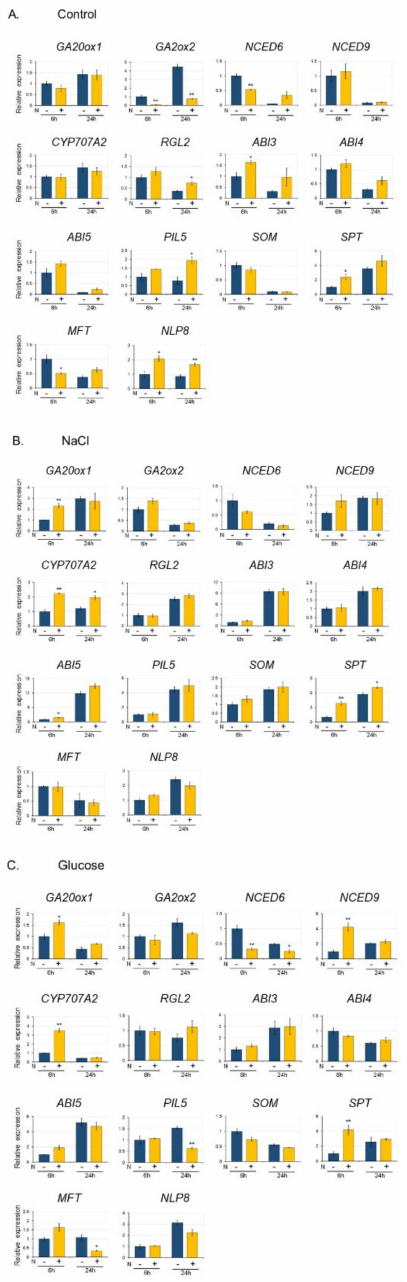
Figure 5. Expression of genes involved in the regulation of seed germination in the presence ( + ) or absence ( − ) of 10 mM KNO 3 . Seeds were imbibed in ( A ) control: no additional compounds, ( B ) in the presence of 170 mM NaCl, ( C ) in the presence of 278 mM glucose, for 6 and 24 h, respectively. Gene expression was quantified by qRT-PCR and values are presented as relative to the control seeds (imbibed for 6 h). The expression levels were normalized against the expression of ELONGATION FACTOR1 α A4 ( EF1 α A4 ). Data are presented as the mean ± SD for three replicates. Asterisks indicate a significant di ff erence between the absence ( − ) and the presence ( + ) of KNO 3 at p < 0.01 ( ** ) and p < 0.05 ( * ) (Student’s